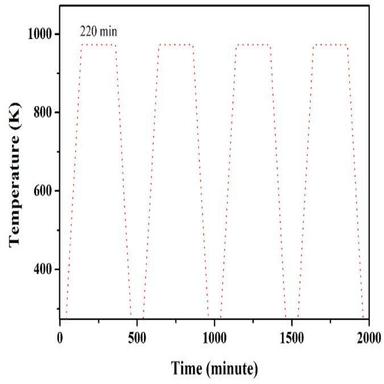
Profile of the thermal cycling test.